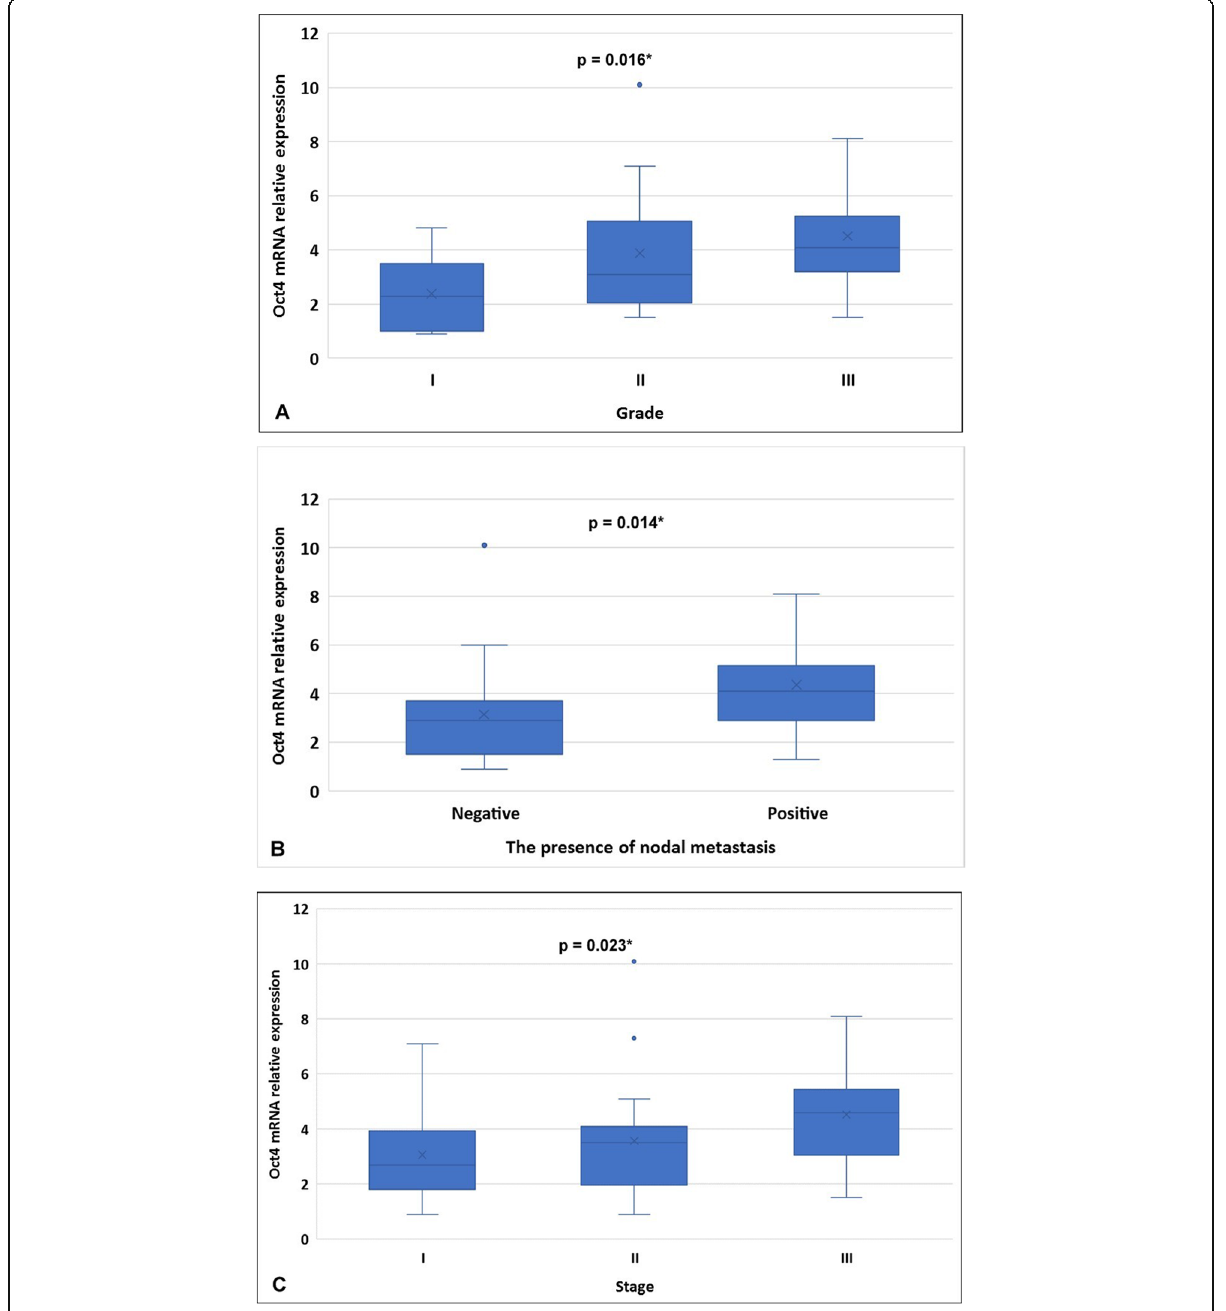
Fig. 3 Relation of Oct4 mRNA relative expression levels and a tumor grade, b nodal metastasis, and c tumor